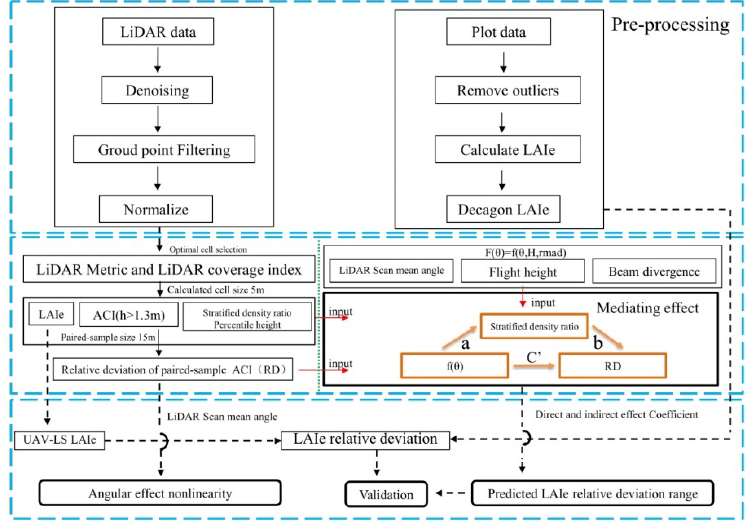
Figure 2. Flowchart. In the figure, a,b represents the indirect effect coefficient and c (cid:48) represents the direct effect